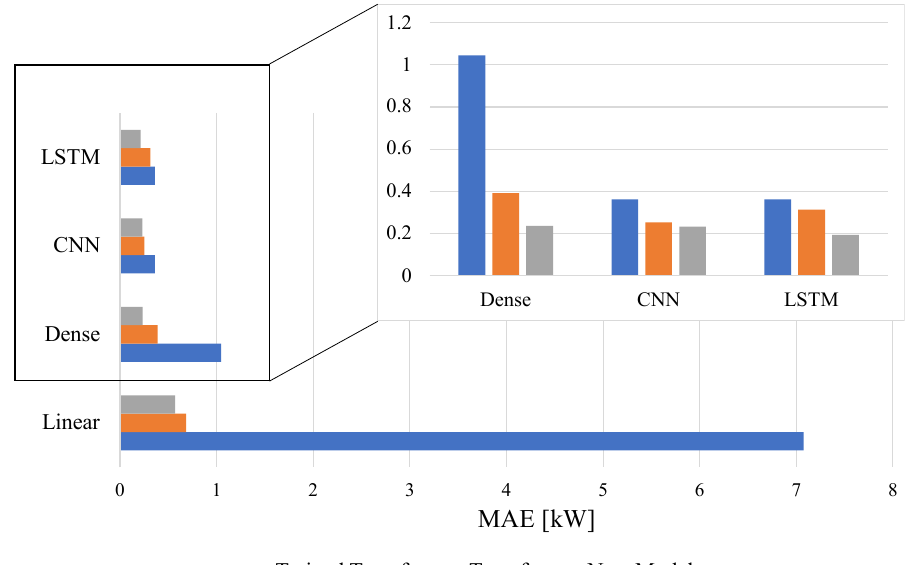
Figure 3. The accuracy of the three sets of models presented in terms of MAE [kW] on the test set of db 2. To thoroughly evaluate the top-performing models, this figure focuses on a close examination of the results obtained from the dense, CNN, and LSTM models. The zoomed-in chart offers a clear and concise comparison of the performance of each model.